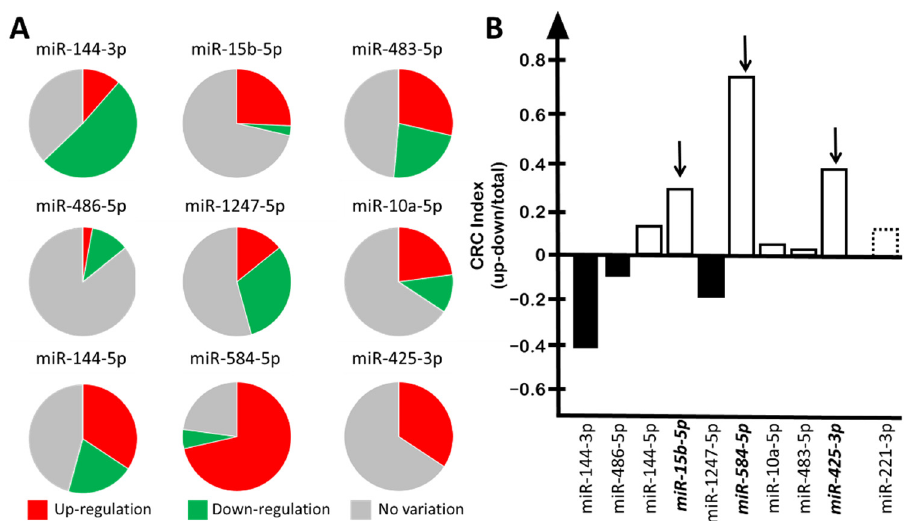
Figure 1. Content of the miRNAs belonging to the “9-miRNA signature” in the plasma from CRC patients. ( A ) Pie chart reporting the number of CRC patients in which each indicated miRNA was found up-regulated (red), down-regulated (green), or to have no substantial variation detected (gray). ( B ) Summary of the “CRC-index” values of the “9-miRNA signature” compared to miR-221-3p. “CRC-index”: (number of patients displaying up-regulation–number of patients displaying down-regulation)/total number of patients analyzed. Up-regulated miRNAs are reported as white boxes, and down-regulated miRNAs as black boxes. Dotted box: miR-221-3p.